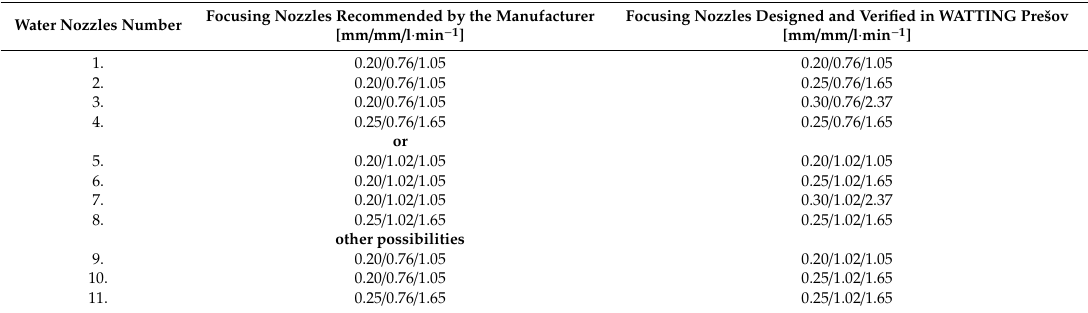
Table 13. Sizing variants for splitting water